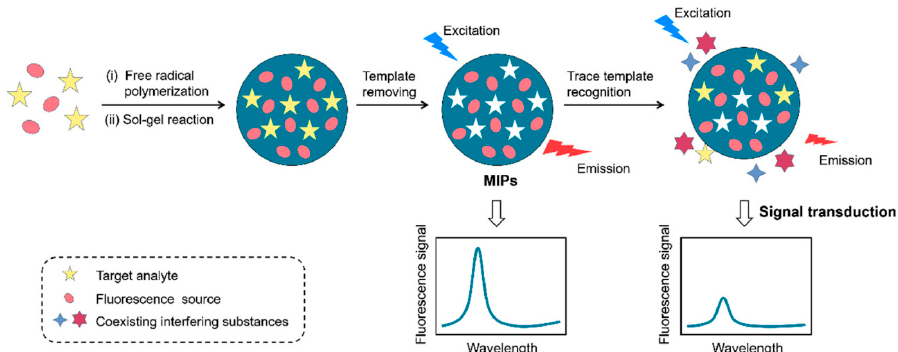
Figure 2. The preparation process of molecularly imprinted fluorescence sensors (MIFs) based on embedding fluorescent materials into MIPs. Reprinted with permission from [45], copyright (2018) Elsevier.